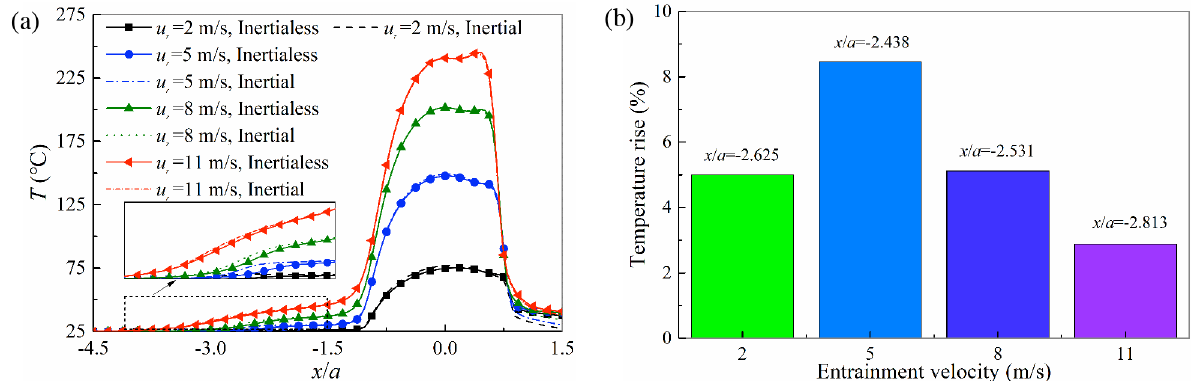
Fig. 11. Effects of inertia on fi lm temperature at varied entrainment velocity ( y =0): (a) fi lm temperature, and (b) maximum relative percentage of temperature rise near